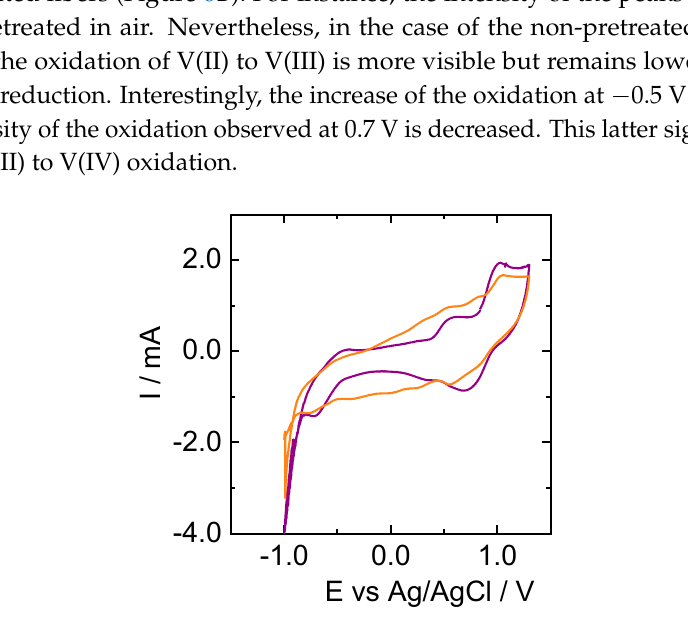
Figure 6. Cyclic voltammograms recorded at 5 mV · s − 1 in 3 M H 2 SO 4 and 0.15 M V(III)/V(IV) solution for KL-based nanofibers electrospun at 7 kV (orange) and 9 kV (purple), both without pre-treatment in air.